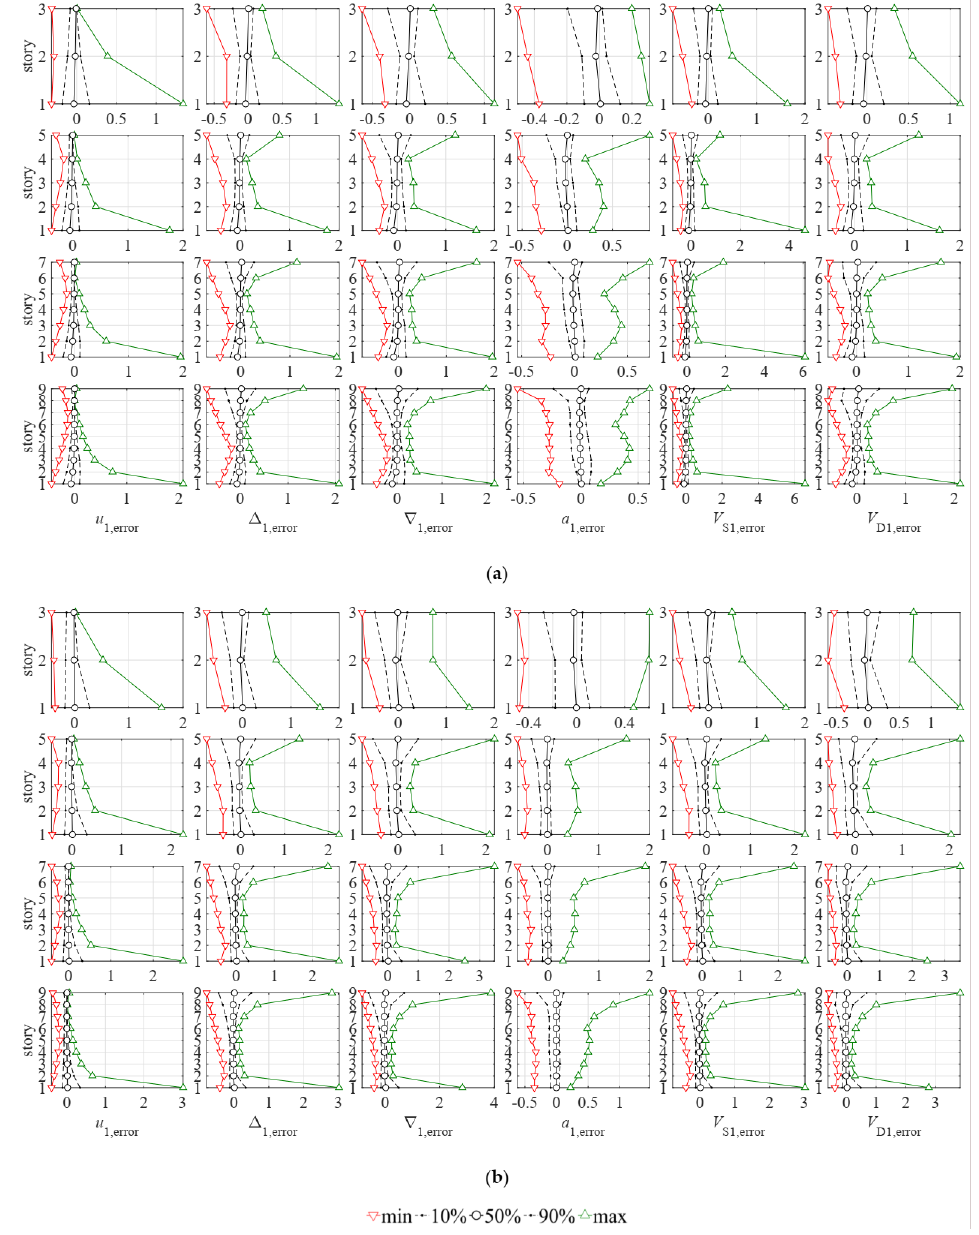
Figure 3. Plots of THMA errors (error 1): ( a ) frame-type system B3-1; ( b ) shear-type system B3- ∞